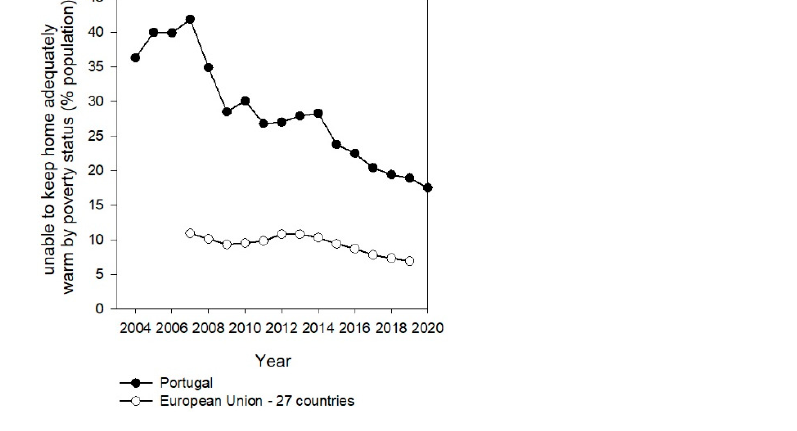
Figure 6. Proportion of inhabitants living in a dwelling with a leaking roof, damp walls, floors or foundation, or rot in window frames or floor (data source [68]). Figure 7. Share of the total population falling behind on utility bills (data source [70]).